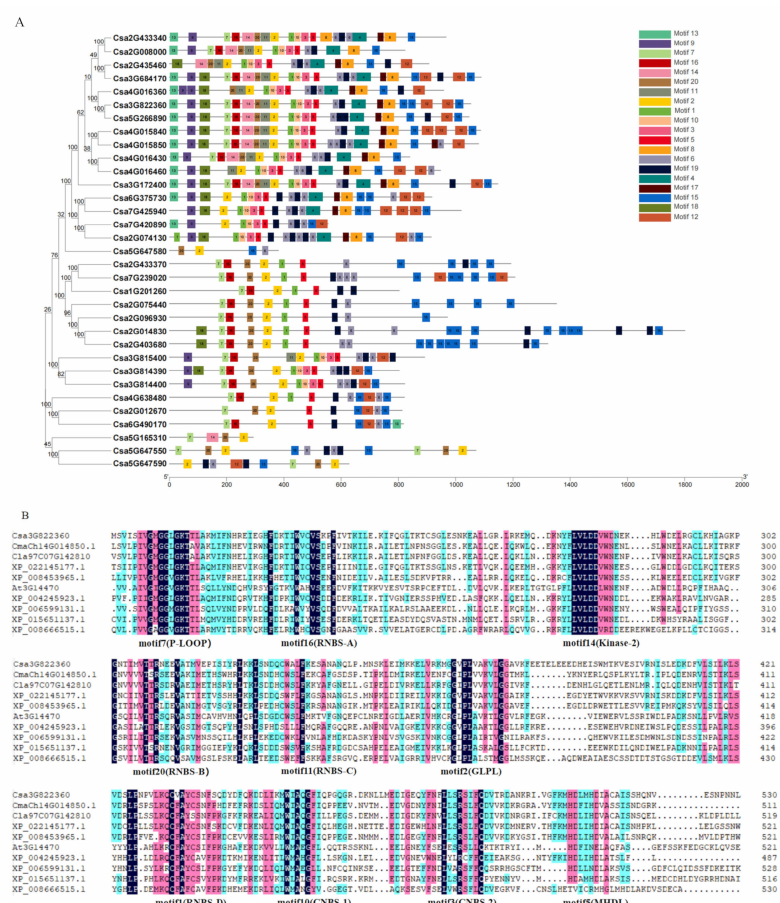
Figure 3. Analysis of the conserved motifs of CNL proteins. ( A ) MEME analysis of the CNL proteins in cucumber plants. ( B ) Alignment of the conserved NBS domain of CNL proteins be- tween cucumber and other species. Black color: the homolog level was 100%; Pink color: the homolog level was greater or equal to 75%; Blue color: the homolog level was greater or equal to 50%. Maize, XP_008666515.1 ; bitter melon, XP_022145177.1 ; melon, XP_008453965.1 ; tomato, XP_004245923.1 ; soybean, XP_006599131.1 ; pumpkin, CmaCh14G014850.1 ; Arabidopsis , At1G10920 ; watermelon, Cla97C07G142810.1 ; and rice, XP_015651137.1